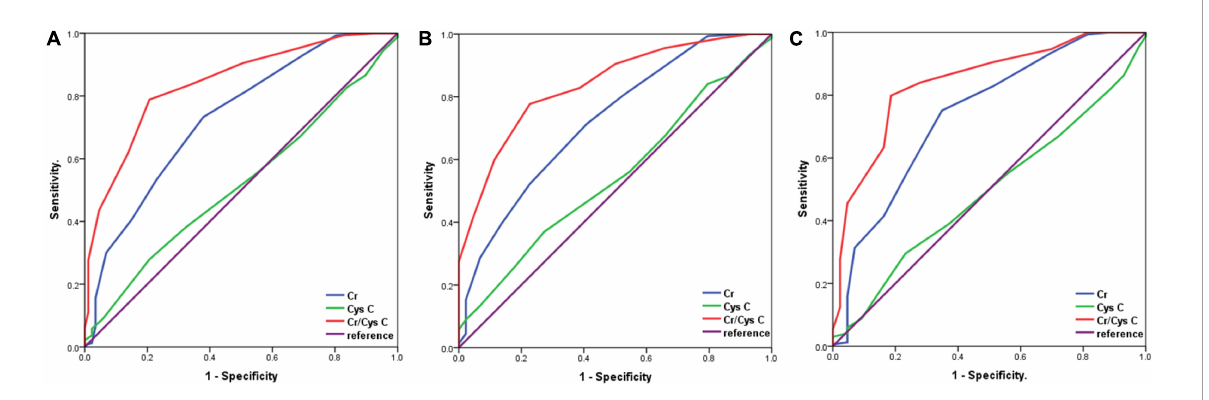
FIGURE1 Receiver operator characteristic curves for the analysis of serum Cr/CysC ratio, CysC and Cr levels for the diagnosis of sarcopenia according to gender. (A) , All patients; (B) , Male patients; (C) , Female patients.